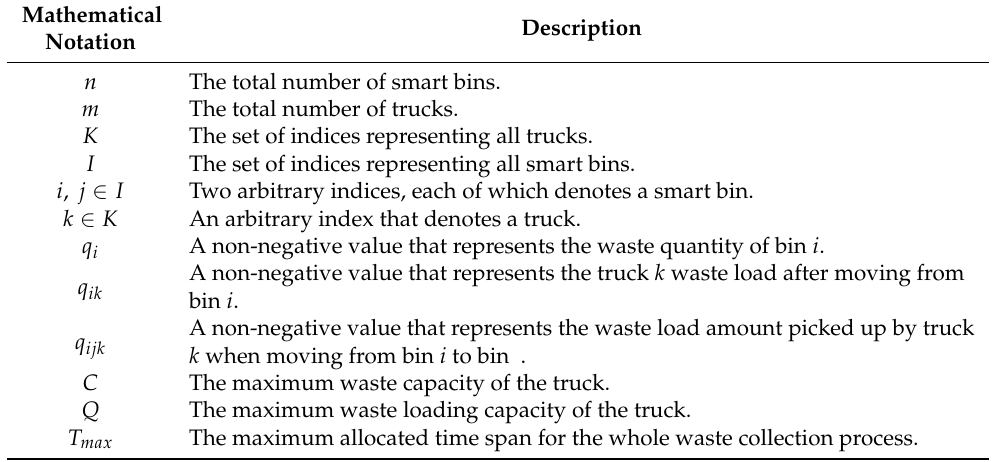
Table 1. Mathematical notations